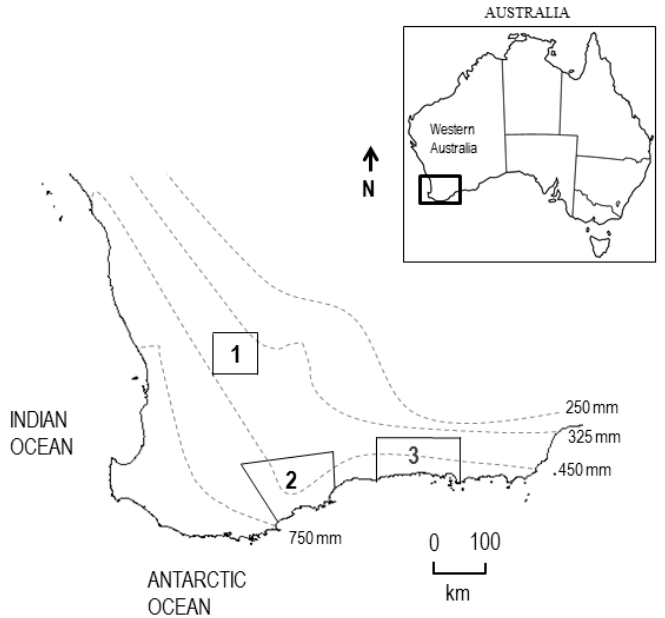
Figure 4. Map of Australia showing where the south-west Australian grain-growing region (grainbelt) is located. Insert shows the three zones in which loop-mediated isothermal amplification (LAMP) protocol field validation sites were located with 250 to 750 mm rainfall isohyets that makes the grainbelt